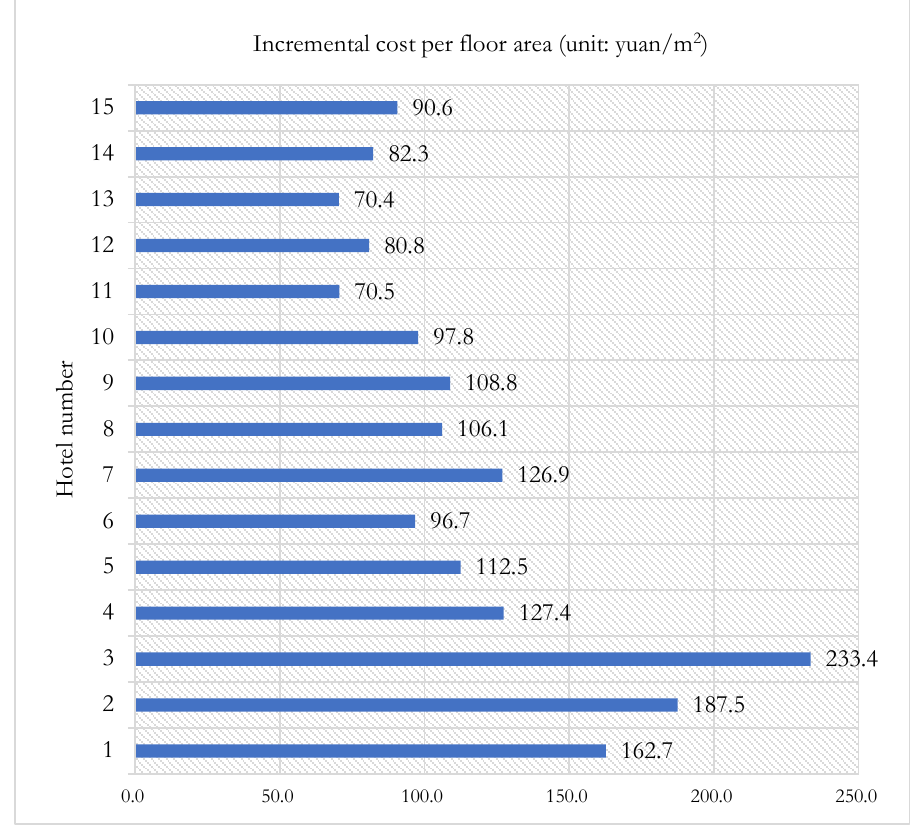
Figure 2. Comparison of incremental cost per floor area.